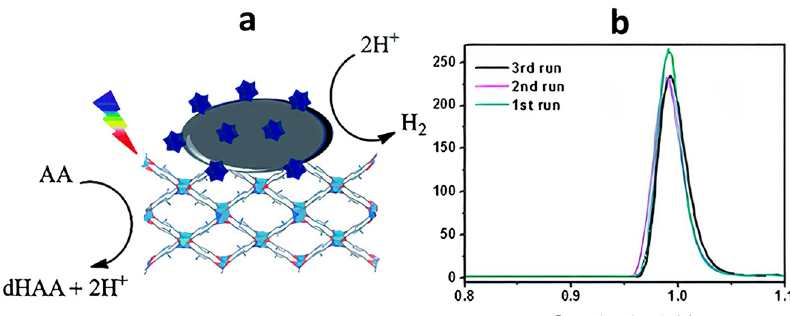
reused catalyst up to three cycles (Figure 6b) demonstrated almost comparable ef fi ciency for H